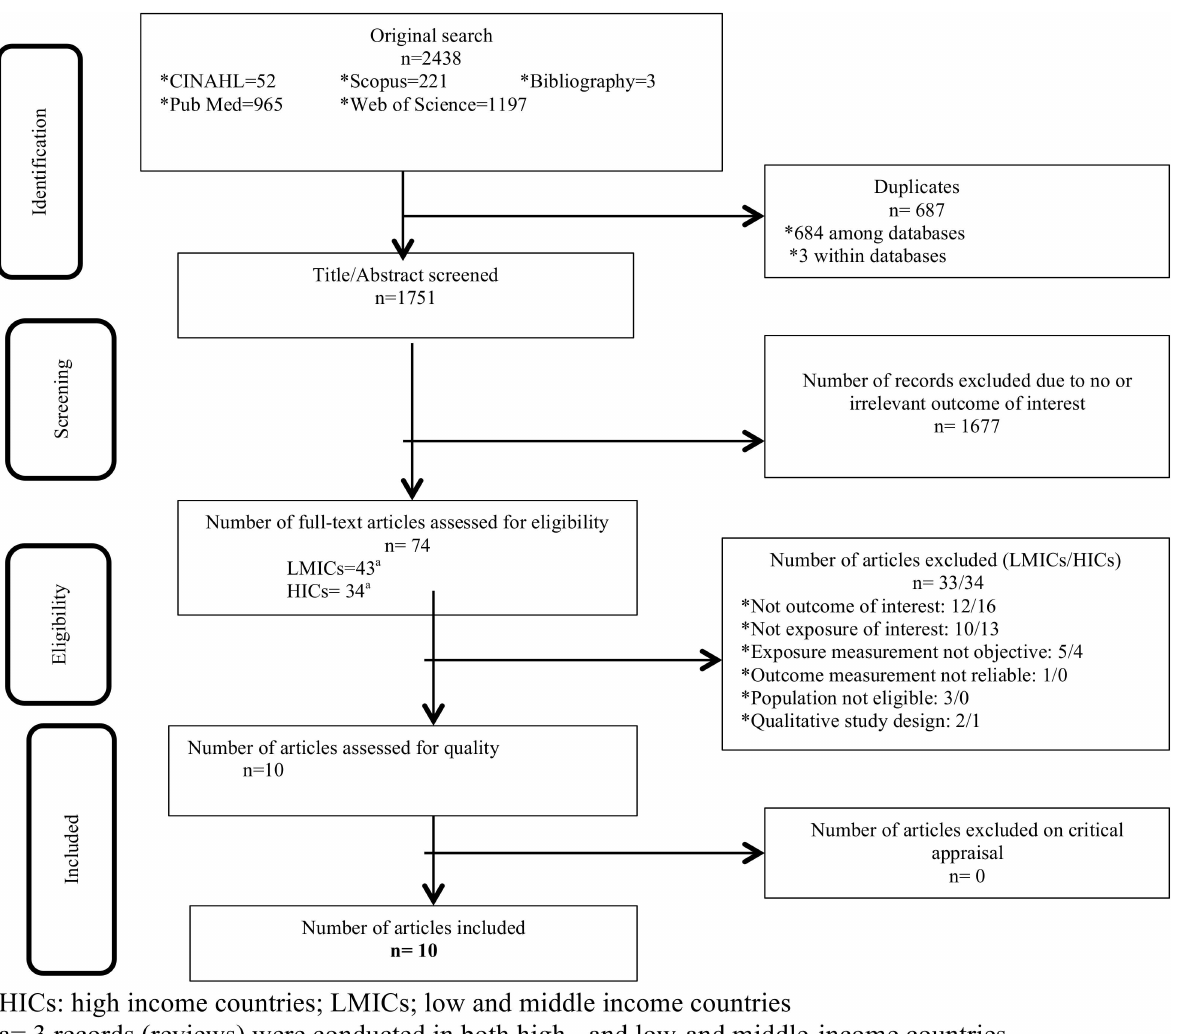
Fig 1. PRISMA 2009 Flow Diagram. This figure presents the results of the systematic search and reasons of